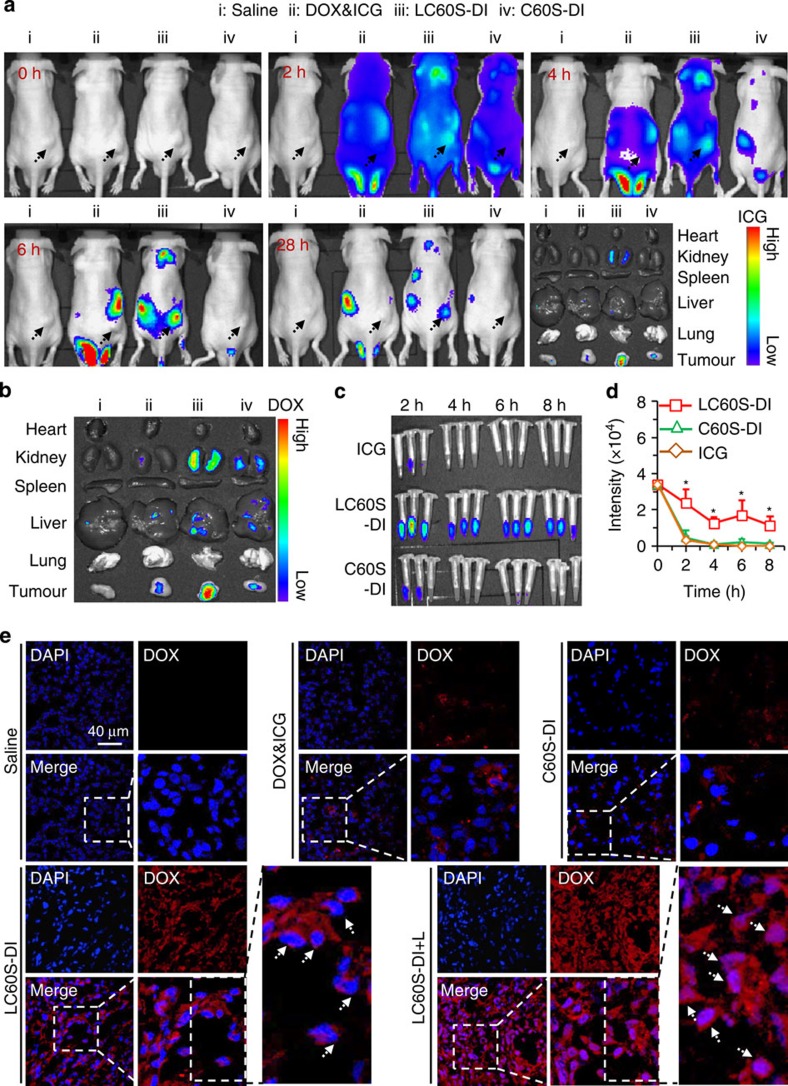
Enhanced and controlled drug delivery to tumour.(a) In vivo whole animal imaging of ICG fluorescence at different times after intravenous injection via the tail vein in the forms of free DOX&ICG, LC60S-DI nanoparticles and C60S-DI nanoparticles together with ex vivo imaging of ICG in tumour and five different organs collected after killing the mice at 28 h. The arrows indicate the locations of tumours in mice. (b) Ex vivo imaging of DOX fluorescence in the same tumour and organs. (c) Images and (d) the corresponding intensity of ICG fluorescence in blood drawn from the mice injected with LC60S-DI nanoparticles, C60S-DI nanoparticles and free ICG. The data indicate a significantly prolonged half-life of the LC60S-DI nanoparticles in blood circulation, compared with free ICG and C60S-DI nanoparticles. Error bars represent±s.d. (n=3). *P<0.05. (Kruskal–Wallis H test). (e) Fluorescence images of DOX in tumour of mice killed at 28 h post injection with saline, DOX&ICG, C60S-DI nanoparticles and LC60S-DI nanoparticles (with and without laser irradiation right before sacrificing the mice). The arrows indicate that for the treatment with LC60S-DI nanoparticles, NIR irradiation induces release of DOX from the nanoparticles so that it can enter the nuclei of cancer cells in tumour in vivo. Otherwise, the DOX stays with the nanoparticles in the cytosol with minimal cytotoxicity. The unspecified ratios of DOX to empty nanoparticle and DOX to ICG for making the DOX- and ICG-laden nanoparticles were 1:20 and 2:1, respectively. All the NIR laser irradiation was for 3 min at 0.7 W cm−2.